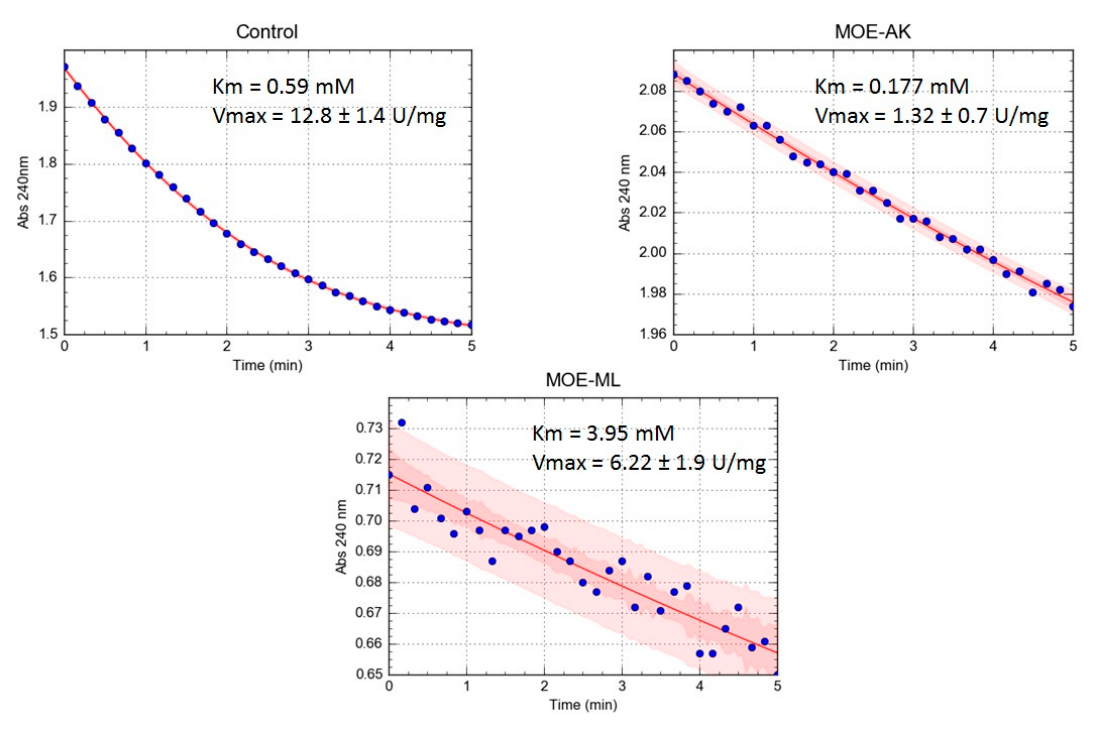
Figure 2. Calculation of Km and Vm from substrate concentration versus time plots. The image shows a representative trace of five repetitions for each rat of a different